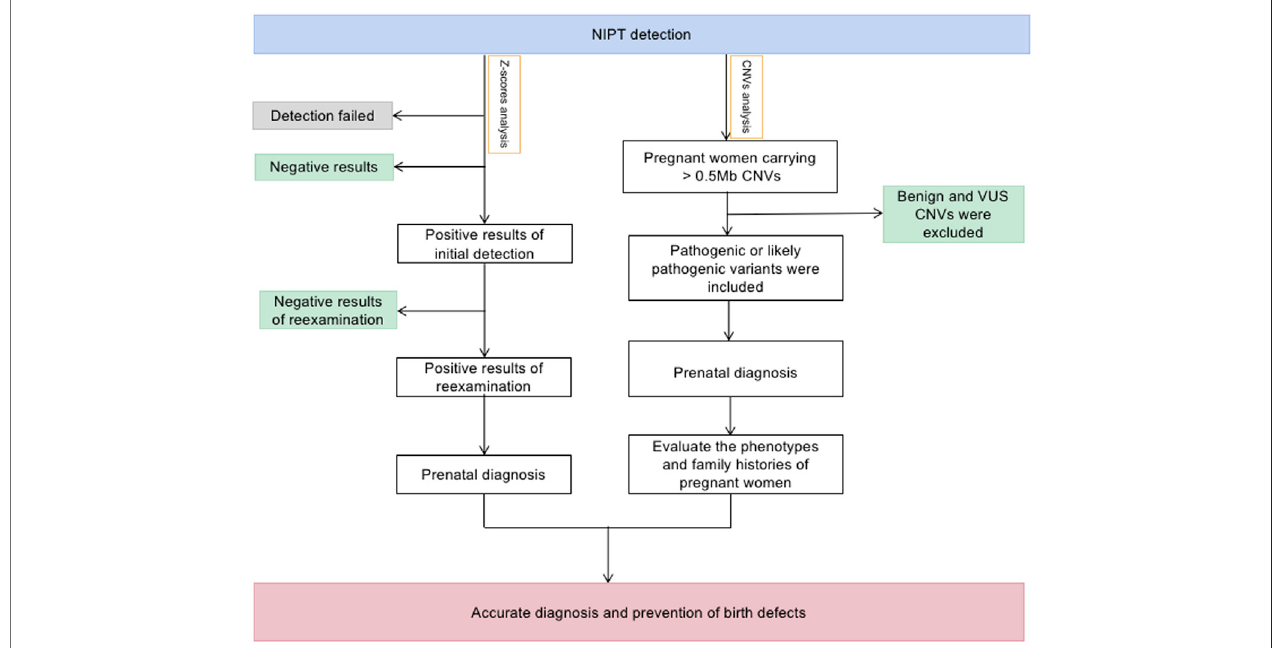
FIGURE 4 | The fl ow of NIPT combining Z-score and maternal CNVs